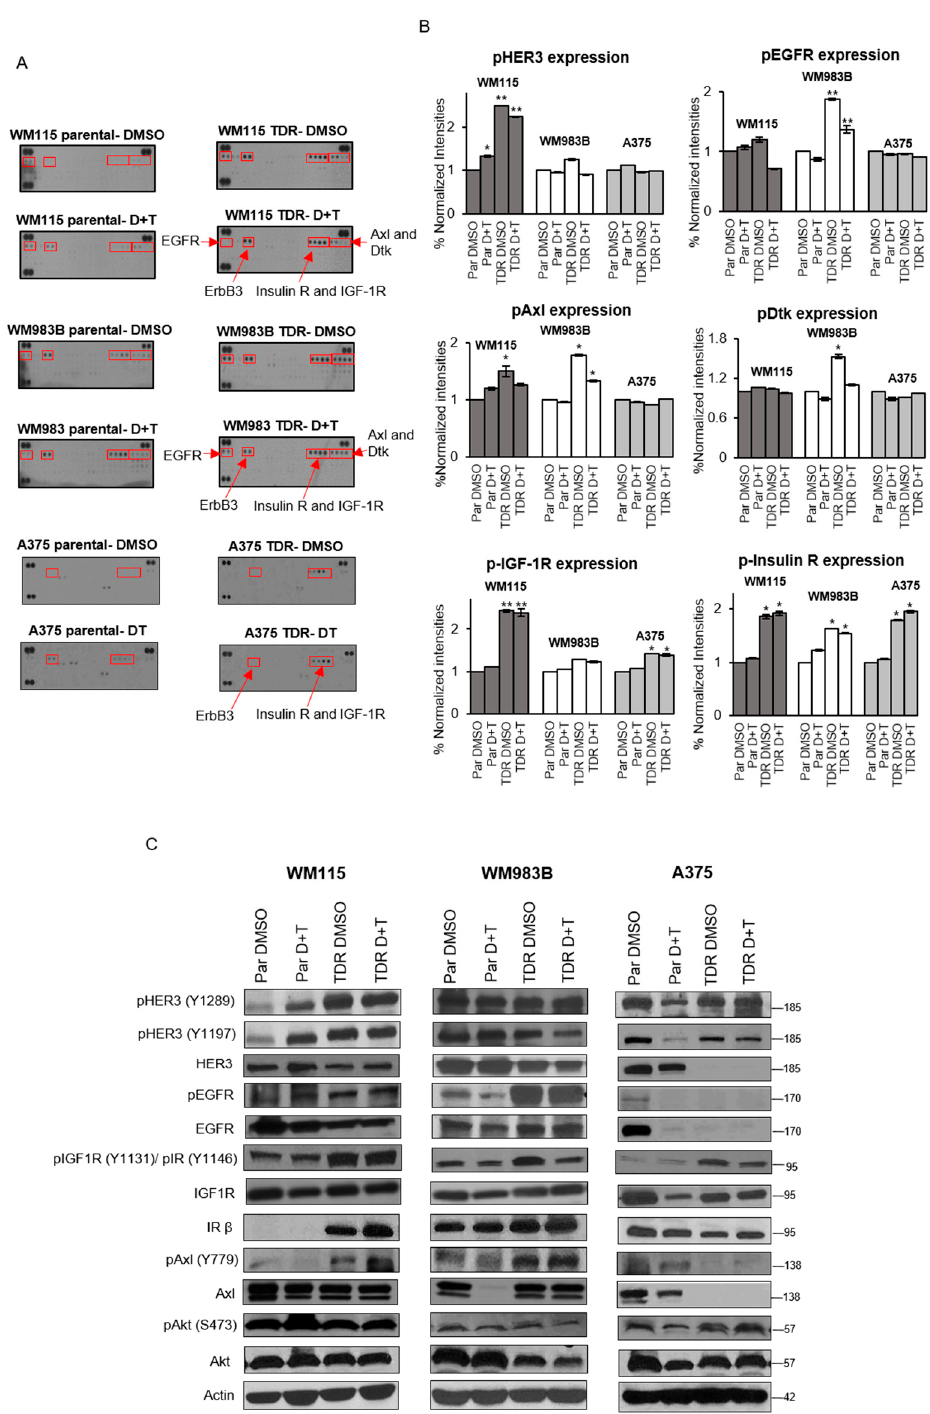
Figure 2. Upregulation of IGF1R and IR kinase activity in BRAF-mutant melanoma cells resistant to BRAF and MEK inhibitors. ( A ) Parental and TDR cells (WM115, WM983B, and A375) either treated with DMSO or combination of dabrafenib (D) and trametinib (T) (WM115: D: 800 nM, T: 200 nM; WM983B: D: 2.4 µ M, T: 500 nM; A375: D: 250 nM, T: 12.5 nM) for 24 h. The red boxes indicate the receptors with altered tyrosine kinase activity. Each RTK spotted in duplicate with positive controls in the corner. ( B ) The average signal density of spots normalized to parental DMSO group; p -values were computed using GraphPad Prism 7.0. * p < 0.05; ** p < 0.001 by two-tailed Student’s t -test. Data are presented as mean ± SEM. ( C ) Immunoblot analysis of parental and TDR cells treated with DMSO or combination of dabrafenib and trametinib (D + T) for 24 h. Whole cells were analyzed using Western blot with indicated antibodies. Actin served as the loading